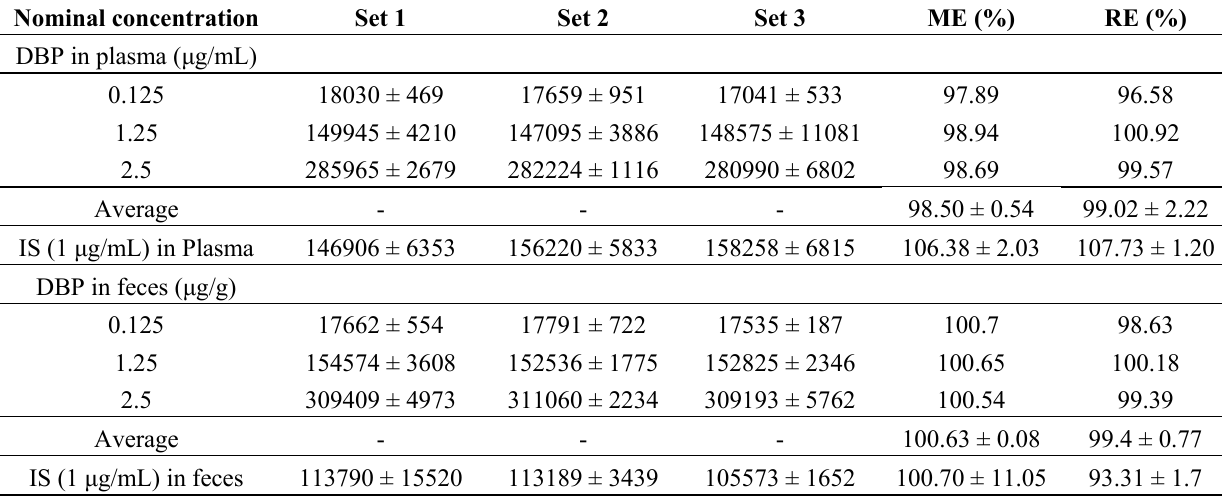
Table 3. Matrix effect (ME) and recovery (RE) data for DBP and chrysin (IS) in rat plasma and feces. Nominal concentration Set 1 Set 2 Set 3 ME (%) RE (%) DBP in plasma ( μ g/mL) 0.125